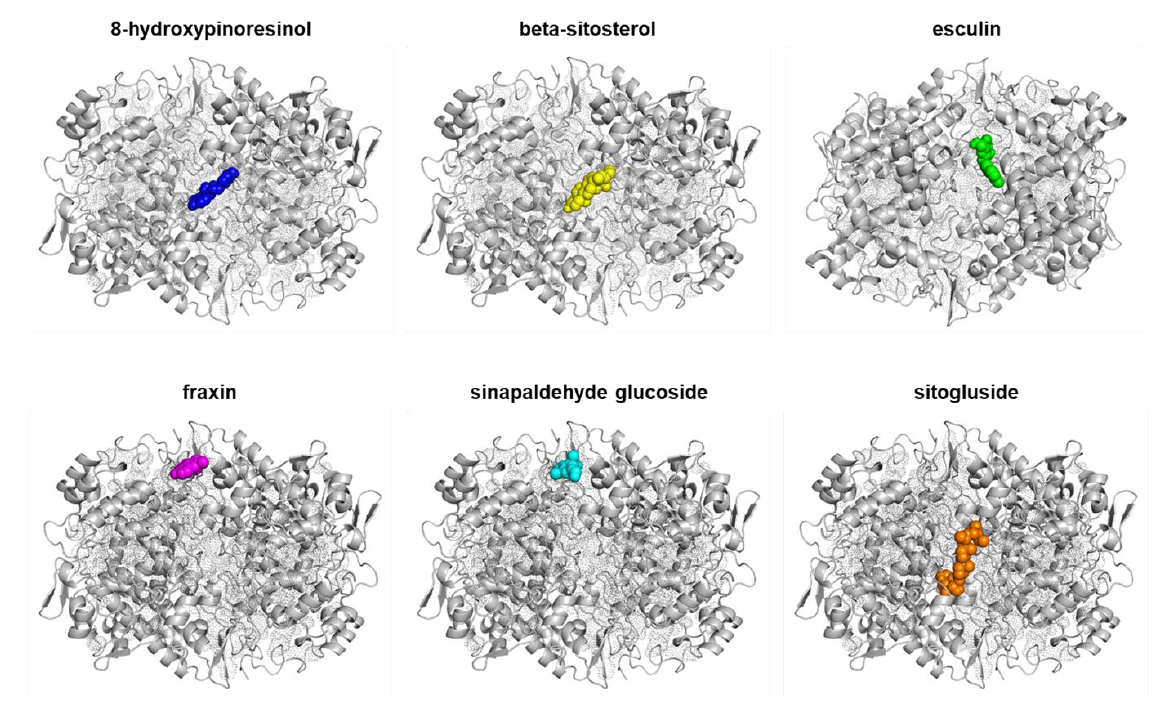
Figure 3. Binding modes of six active compounds and COX-2 Macromolecule (grey cartoon) means COX-2.